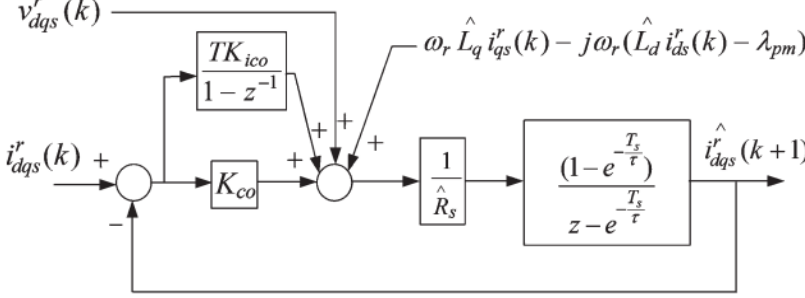
Figure 2. A block diagram of a stator current observer in a discrete time domain.